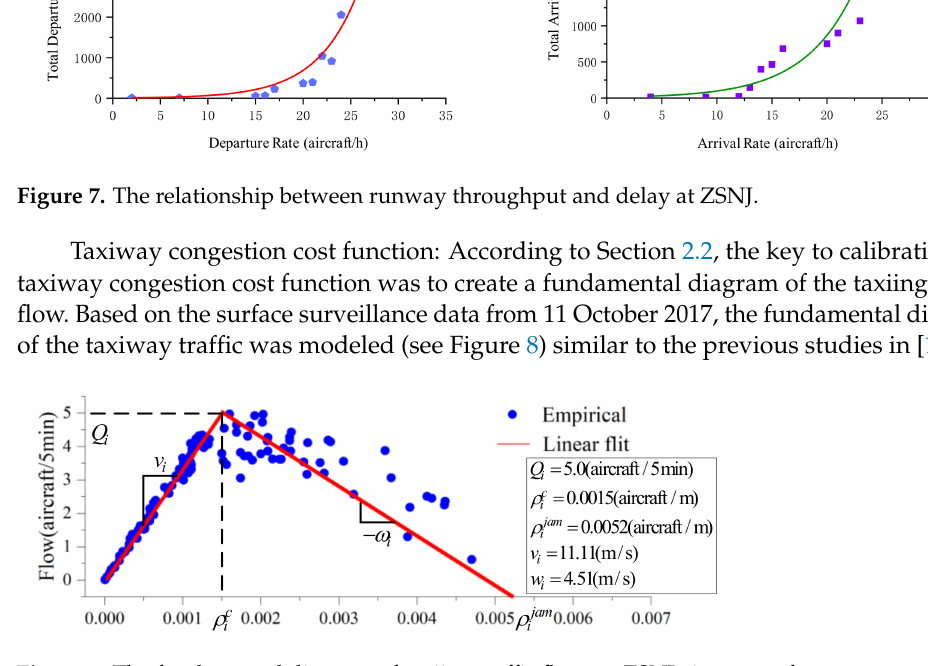
Figure 8. The fundamental diagram of taxiing traffic flow on ZSNJ airport